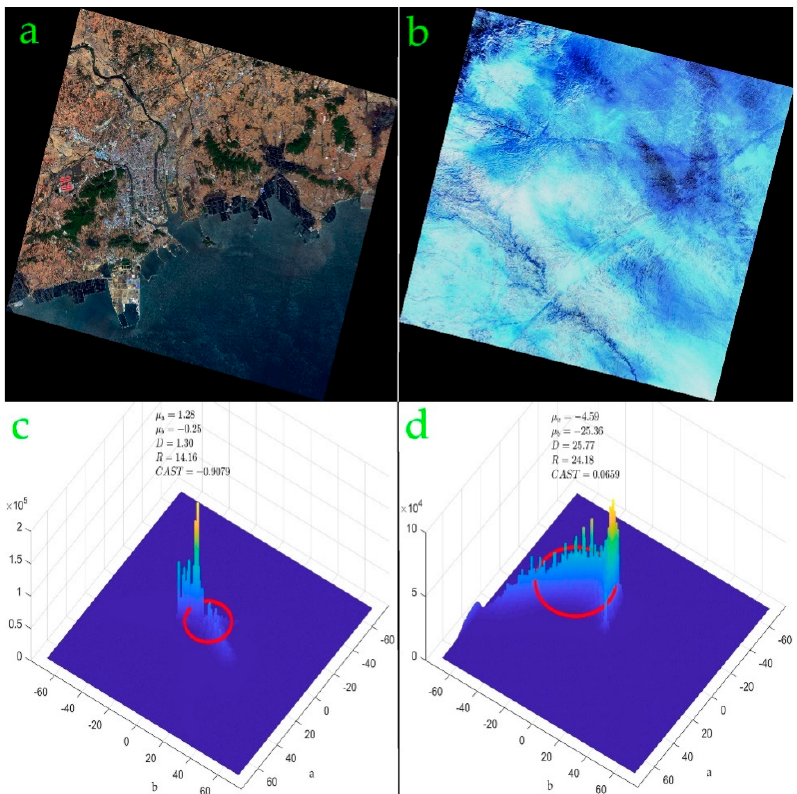
Figure 2. The 2D histogram of ab plane in CIELAB color space ( a ) a satellite image with normal color, ( b ) a satellite image with color cast, ( c ) 2D histogram of image a, ( d ) 2D histogram of image b. The red circles in ( c ) and ( d ) are the equivalent circles mentioned above. Compared with color cast images, normal images have smaller equivalent circles that are closer to the neutral axis. The CAST of normal images is close to − 1, while that of color cast ones is usually greater than 0 and close to 1. Best viewed in color.